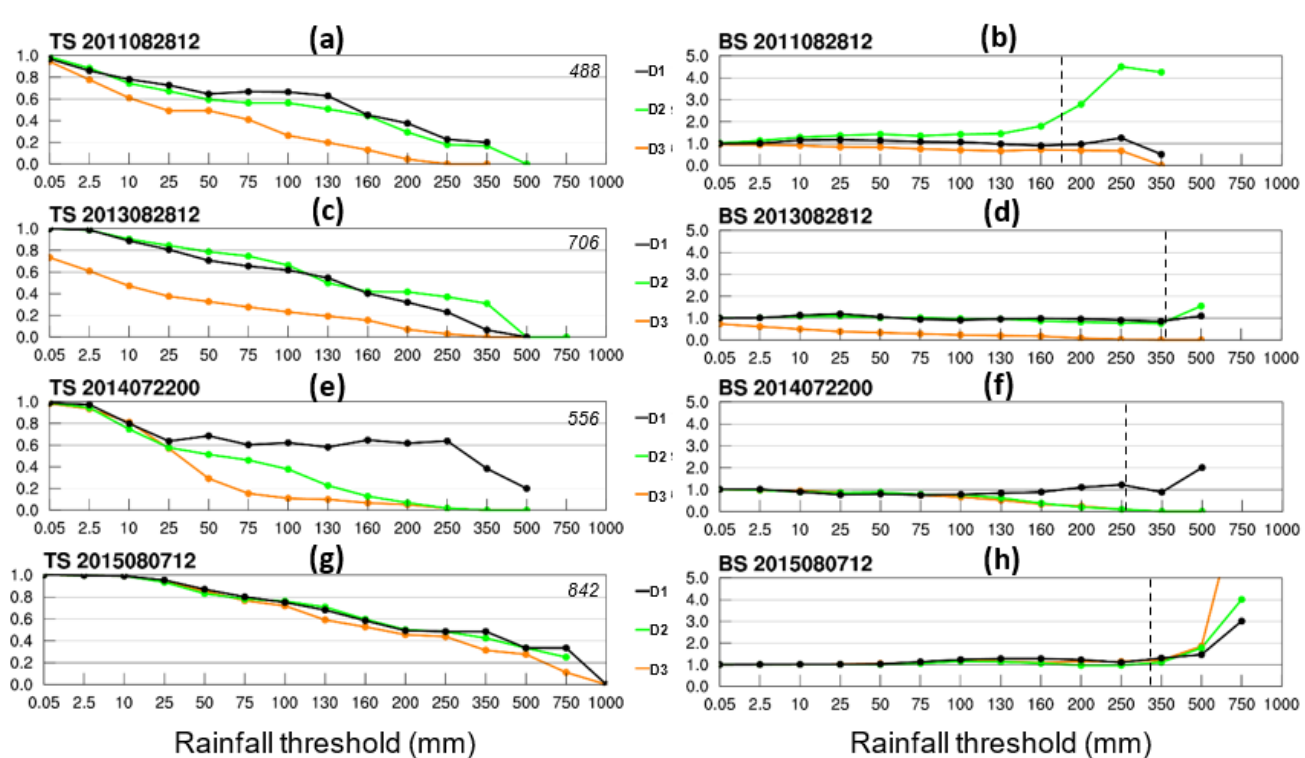
Figure 12. As in Figure 10, except for TS and BS of 24 h, QPFs made at ( a , b ) 1200 UTC of 26–28 August but all targeted for the period of 1200 UTC 28 to 1200 UTC 29 August during TY Nanmadol (2011), ( c , d ) 1200 UTC of 26–28 August but all targeted for the period of 1200 UTC 28 to 1200 UTC 29 August during TY Kong-Rey (2013), ( e , f ) 0000 UTC of 20–22 July but all targeted for 22 July (0000–2400 UTC) during TY Matmo (2014), and ( g , h ) 1200 UTC of 5–7 August but all targeted for the period of 1200 UTC 7 to 1200 UTC 8 August during TY Soudelor (2015), respectively. The observed maximum rainfall (mm, rounded to integer) and base rate ( O / N ) at 10% (vertical dashed line) for the target period are both given.